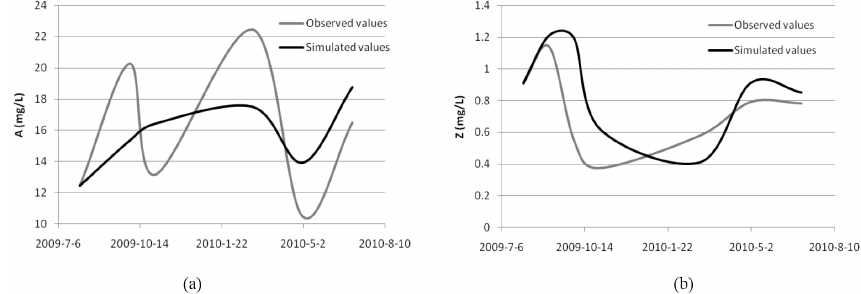
Figure 12. Calibration results for phytoplankton biomass (a) and zooplankton biomass (b) at site 6.